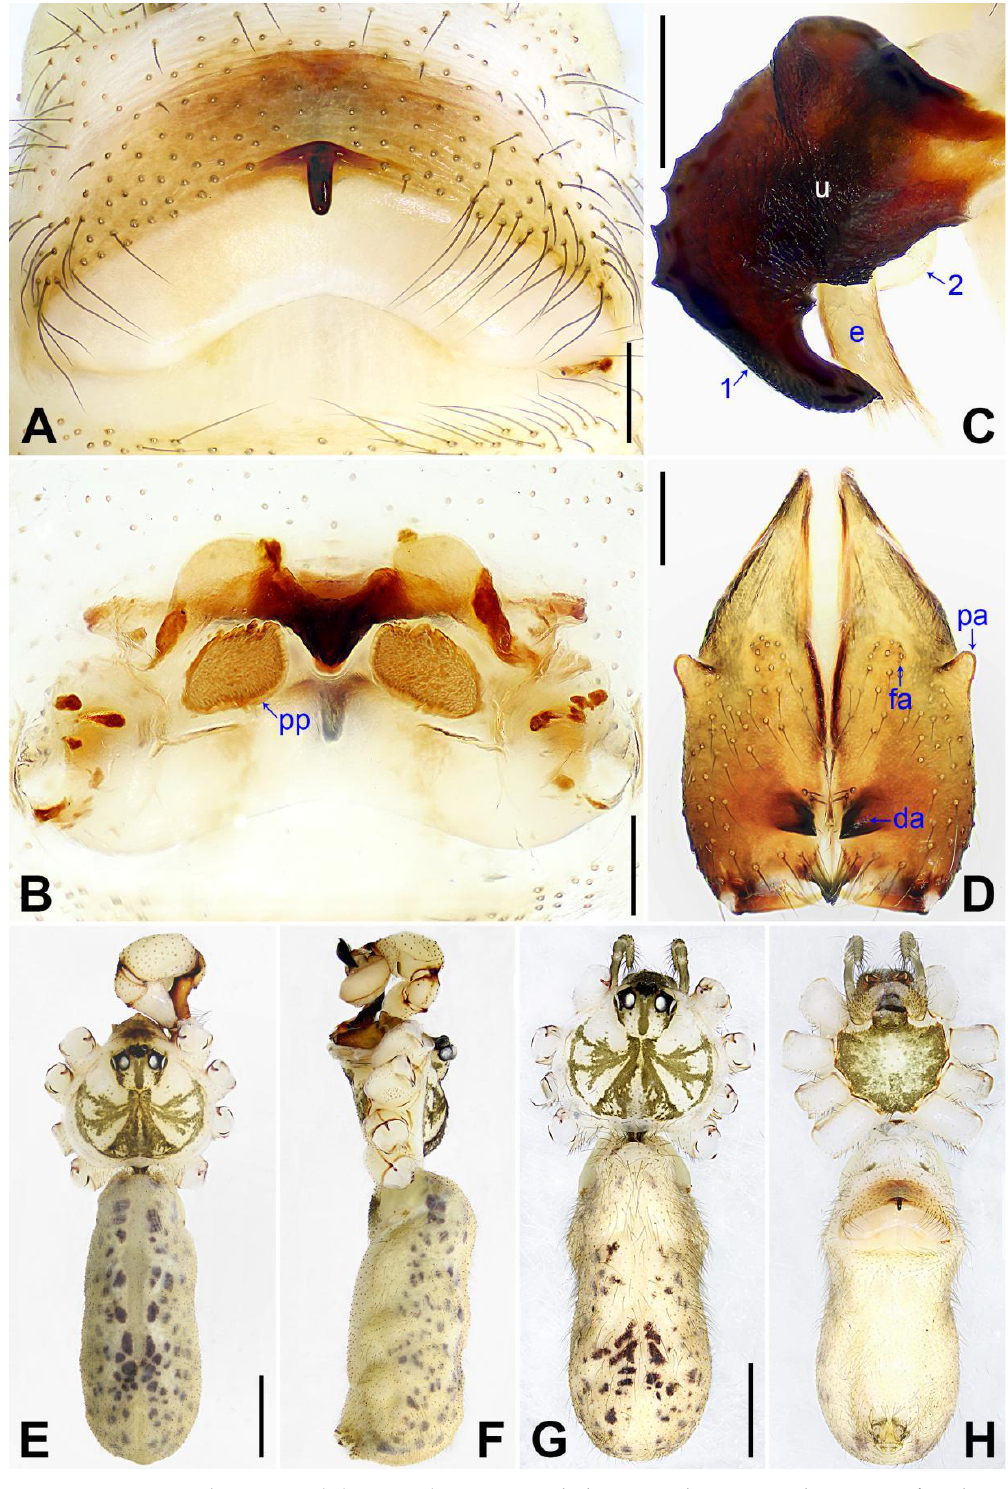
Figure 12. Pholcus wenshui sp. nov., holotype male ( C – F ) and paratype female ( A , B , G , H ): ( A ) epigyne, ventral view; ( B ) vulva, dorsal view; ( C ) bulbal apophyses, prolateral view (arrow 1 points at wide distal apophysis, arrow 2 points at ‘pseudo-appendix’); ( D ) chelicerae, frontal view; ( E ), ( G ) habitus, dorsal view; ( F ) habitus, lateral view; ( H ) habitus, ventral view. da = distal apophysis, e = embolus, fa = frontal apophysis, pa = proximo–lateral apophysis, pp = pore plate, u = uncus. Scale bars: ( A – D ) = 0.20 mm; ( E – H ) = 1.00 mm.